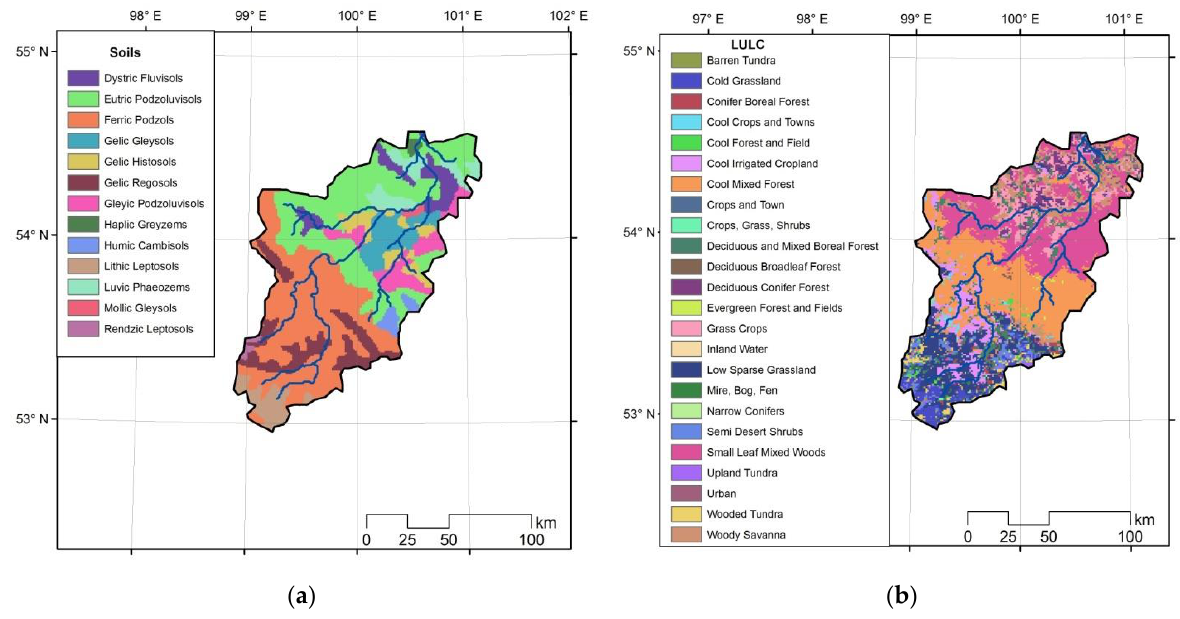
Figure 2. Soil map ( a ) and landuse/landcover map ( b ) of the Iya River basin, according to Harmonized World Soil Database and Global Land Cover